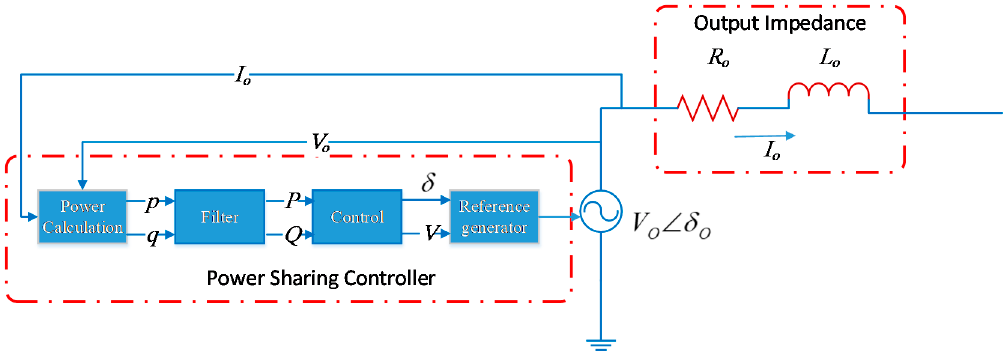
Figure 9. Thevenin equivalent model of an inverter.